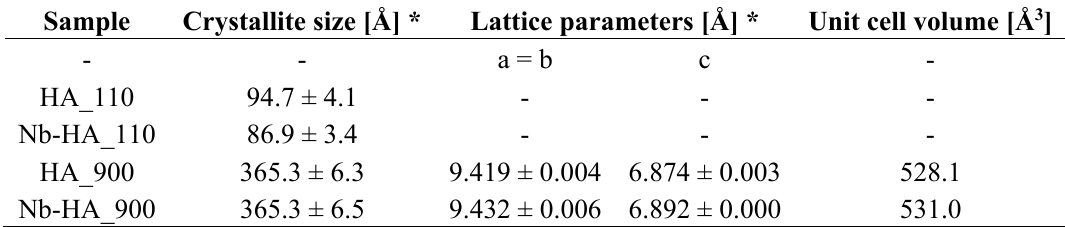
Figure 4. XRD patterns of HA_110 ( A ); Nb-HA_110 ( B ); HA_900 ( C ); and Nb-HA_900 ( D ). Bottom: reference of main peaks of HA (JCPDS, ICDD—96-900-3549). Table 1. Lattice parameters of synthesized